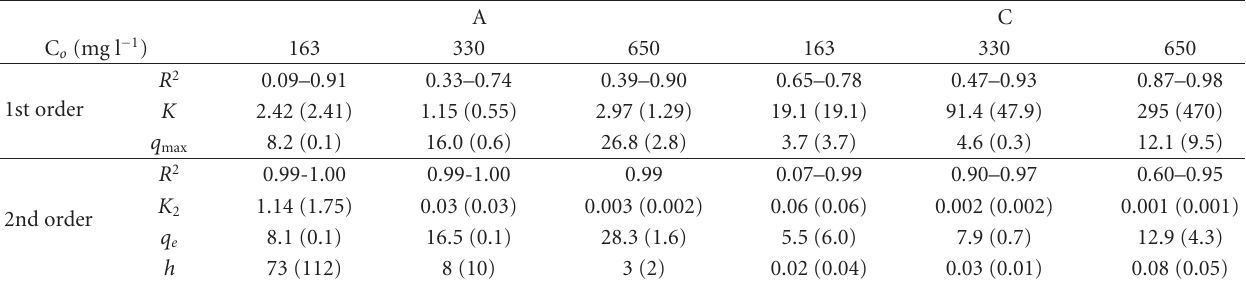
Table 3: Kinetic parameters for Direct Red 23 uptake onto TiO 2 samples A and C. For R 2 , the range of values is shown from the replicate experiments. For other parameters, the data shown are averages with standard errors in parentheses. A